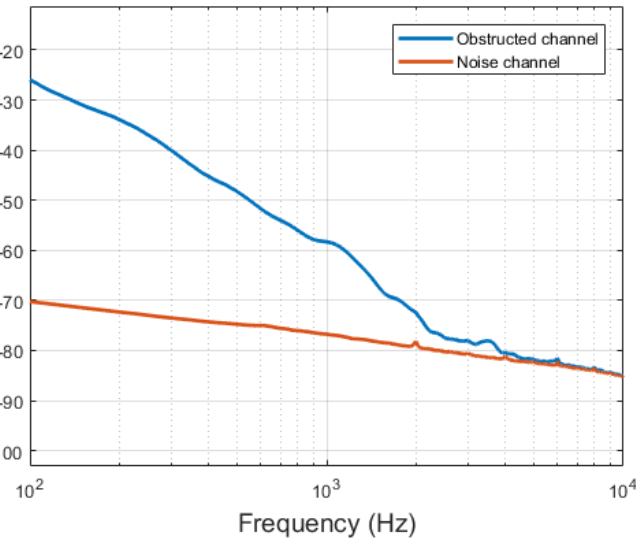
Figure 16. Amplitude spectra of signals acquired during MRI when one channel was manually partially obstructed (blue) versus the second, unaffected channel (red).